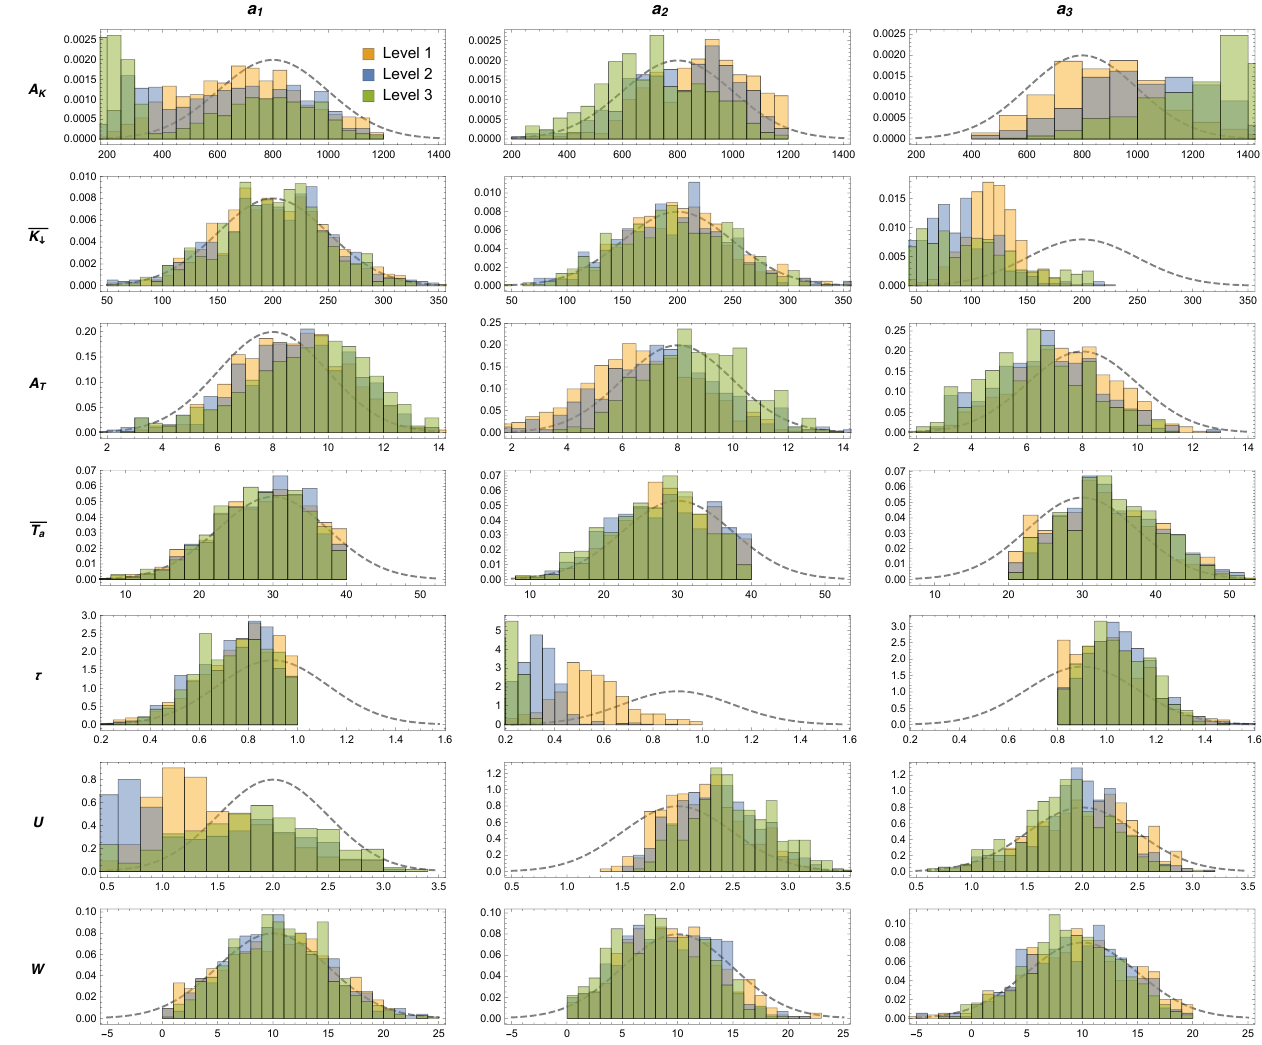
Figure 3. Histograms of conditional samples at different conditional levels for ambient forcing parameters (rows from top: incoming solar radiation amplitude A K in Wm − 2 and its daytime mean K ↓ in Wm − 2 , air temperature amplitude A T in ◦ C and its daily mean T a in ◦ C, the phase lag τ in rad between K ↓ and T a , wind speed U in ms − 1 , and water flux density W in ms − 1 ) with AnOHM coefficients as the model output (columns from left: a 1 , a 2 and a 3 ) . As Fig. 1.